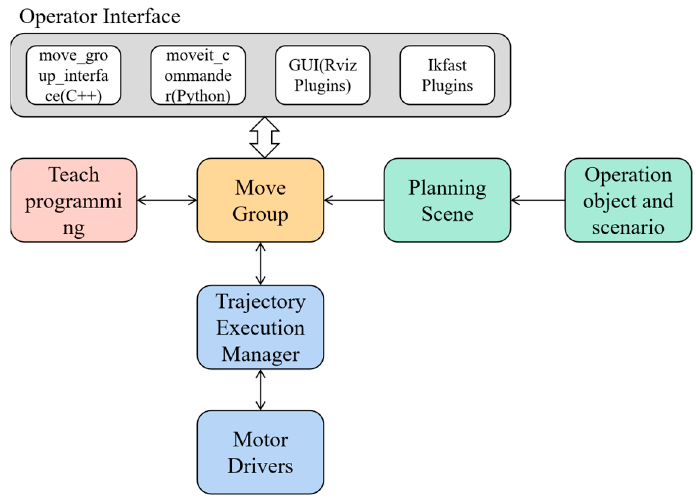
Figure 8. Electrical system design of robot.